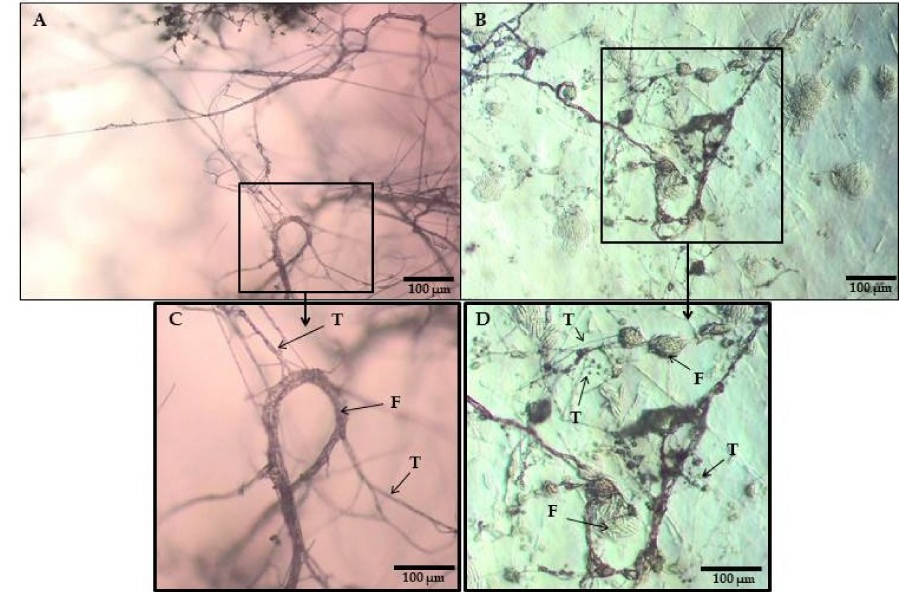
Figure 5. The microscopic (light microscope—LM) evaluation of the interaction of the Trichoderma DEMTkZ3A0 strain on phytopathogens: ( A , C ) F. oxysporum DEMFc38 and ( B , D ) F. culmorum DEMFc37.